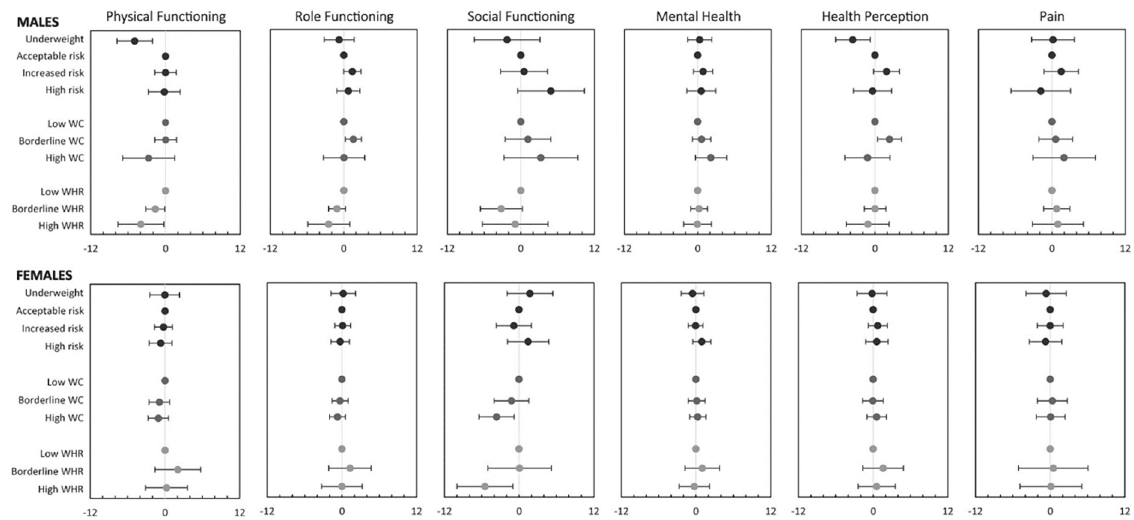
Fig 2. Adjusted differences in means of health-related quality of life dimensions between categories of body mass index (BMI), waist circumference (WC), and waist-to-hip ratio (WHR) by sex. Notes . Multivariable ordinary least squares regression estimates. For each sex and HRQoL dimension, three regressions were estimated. One included BMI categories, another included WC categories, and the third included WHR categories. References categories are indicated by a dot at 0 with no whiskers that elsewhere indicate 95% CI. All regressions included the covariates in Table 1, with age entered as indicators of 5-year intervals and participant and family history of chronic condition excluded. Estimates in table format in S3 Table in S1 File.